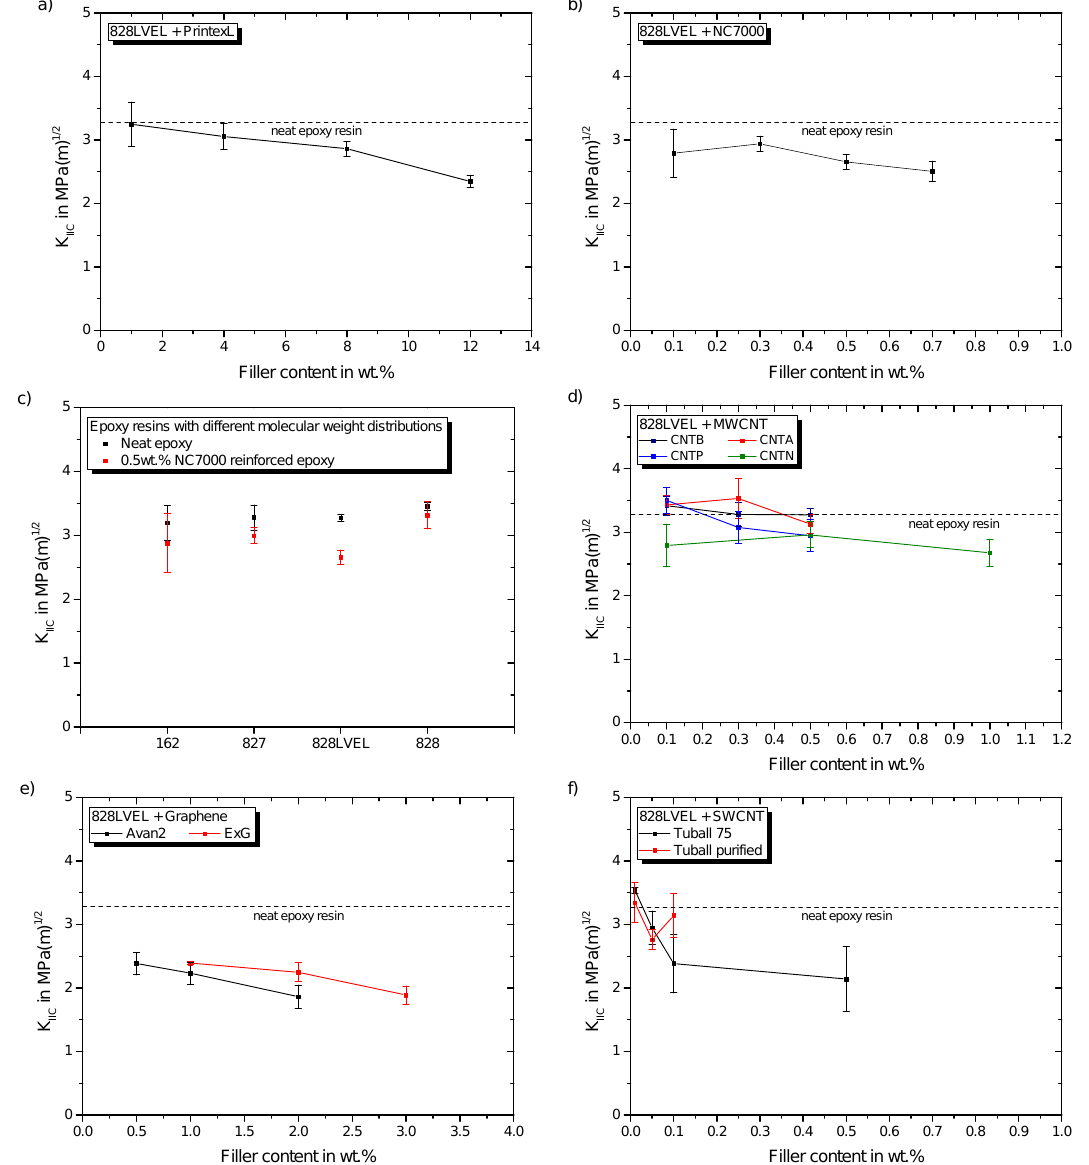
Figure 15. Particles impact on fracture toughness in mode II for ( a ) CB in Epikote 828LVEL ( b ) NC7000 in Epikote 828LVEL ( c ) 0.5wt.% NC7000 in Epikote 162, 827, 828LVEL, and 828 ( d ) CNTB, CNTA, CNTP and CNTN in Epikote 828LVEL ( e ) Avan2 and ExG in Epikote 828LVEL ( f ) Tuball 75 and Tuball purified in Epikote